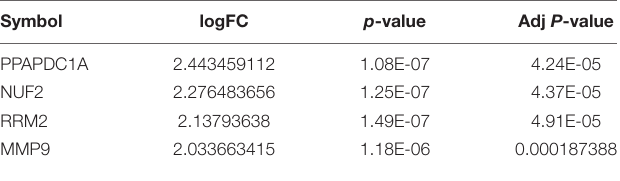
TABLE 2 | Differential expression of candidate genes in GSE61304. Symbol logFC p -value Adj P -value